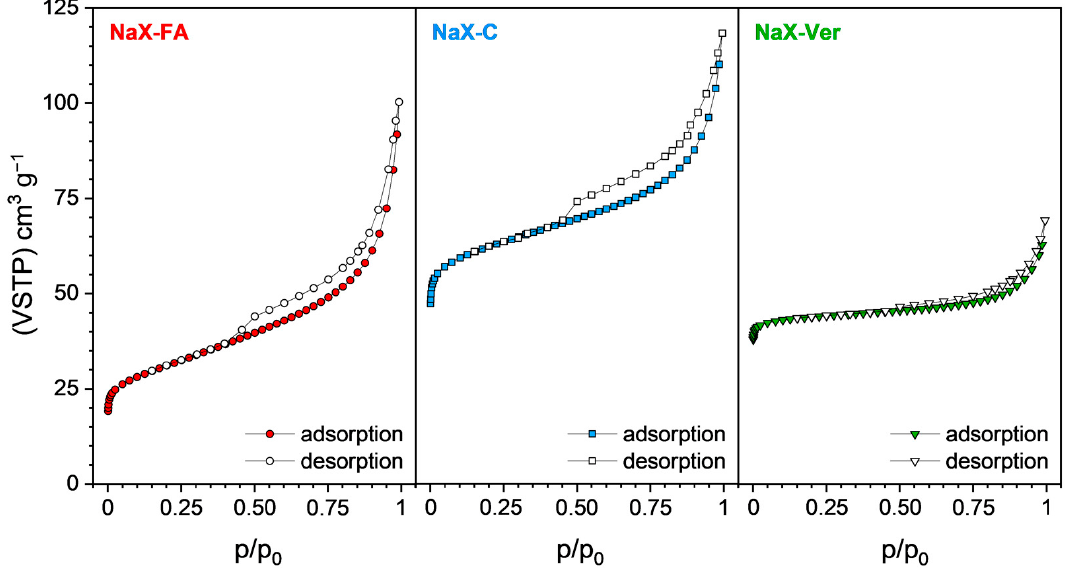
Figure 3. Adsorption–desorption isotherms of N 2 at 77 K for investigated zeolites.